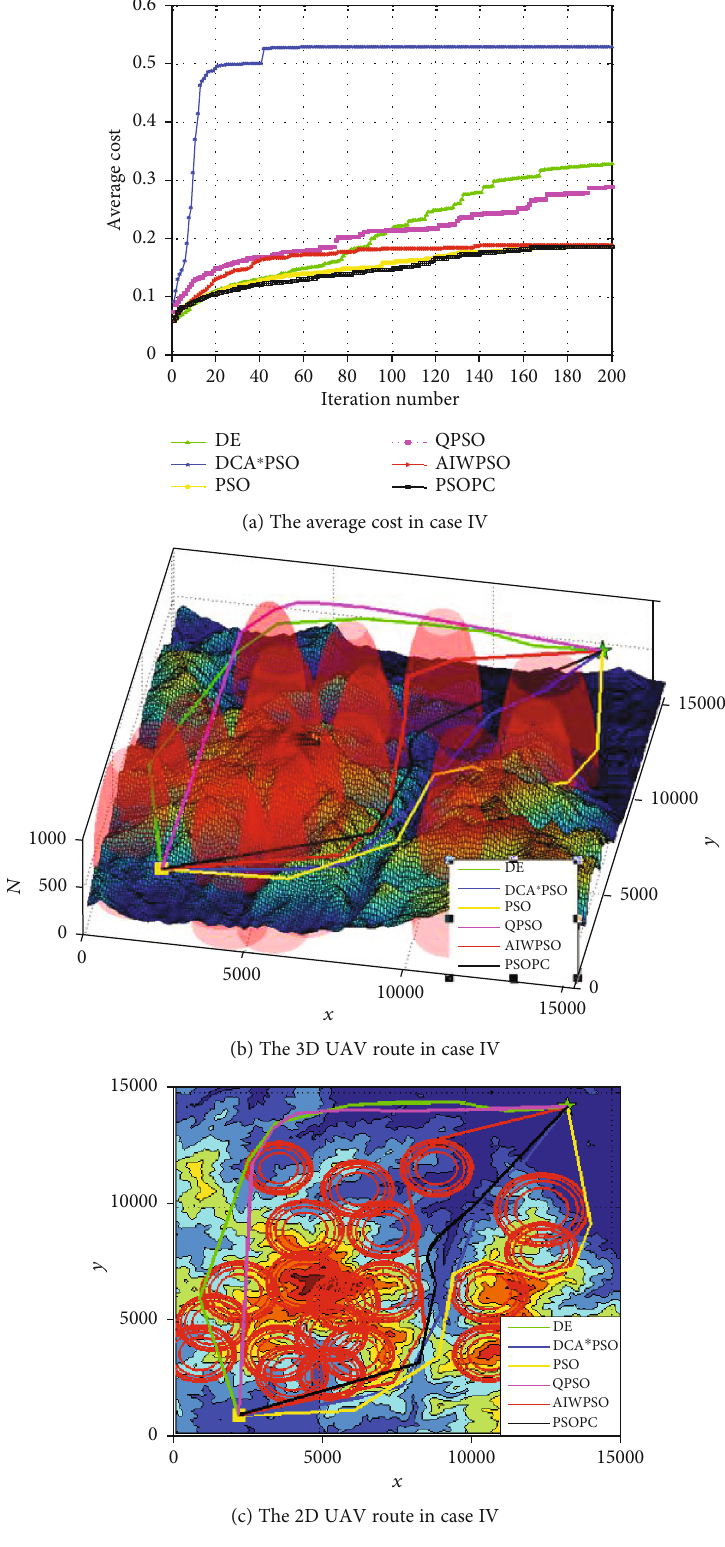
Figure 9: The comparison results of various methods in case